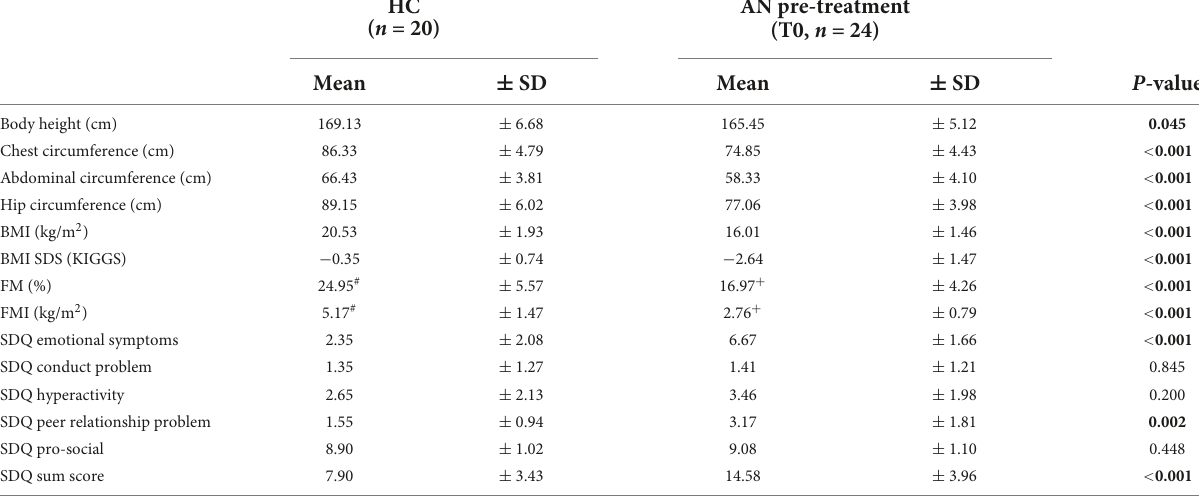
TABLE 1 Characteristics of the study